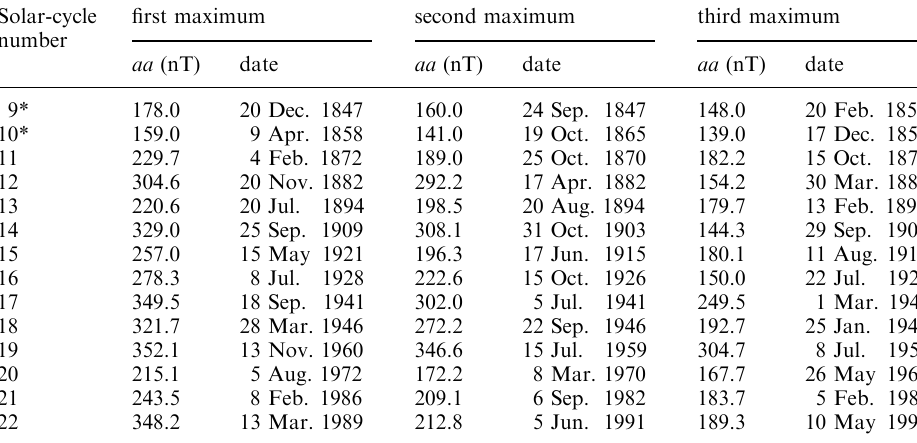
Solar-cycle first maximum second maximum number aa